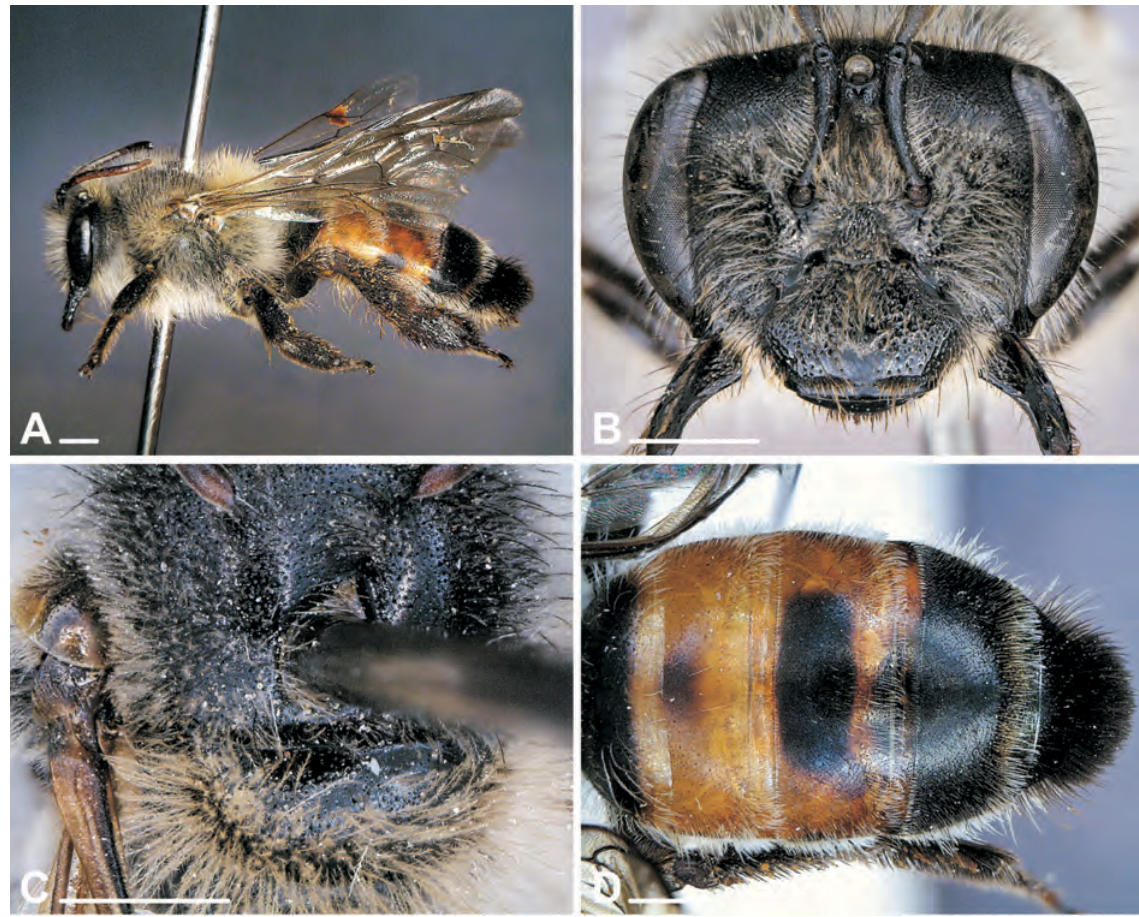
Fig. 6. Redivivoides kamieskroonensis sp. nov., ♀. A . lateral view. B . head. C . Scutum and scutellum. D . Metasoma (dorsal view). Scale bar: 1